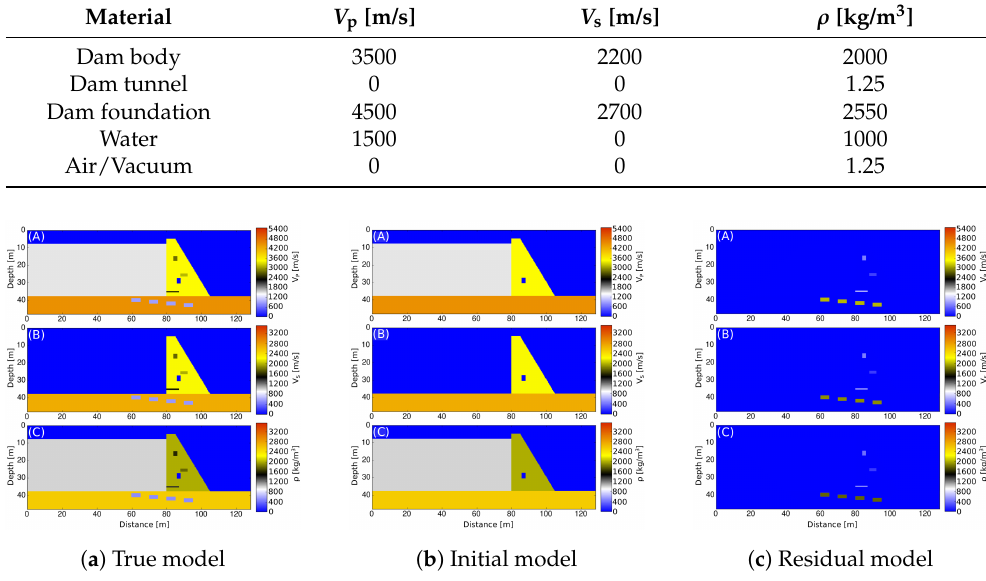
Figure 3. Distribution of seismic velocities and density in the air, water, foundation and dam structure: ( A ) V p distribution, ( B ) V s distribution (note shear waves only travel through solids) and ( C ) ρ